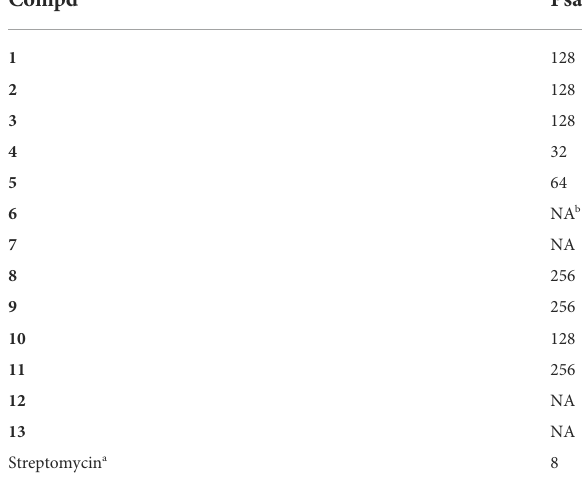
TABLE 4 Inhibitory effects of the isolates against Psa (MIC, μ